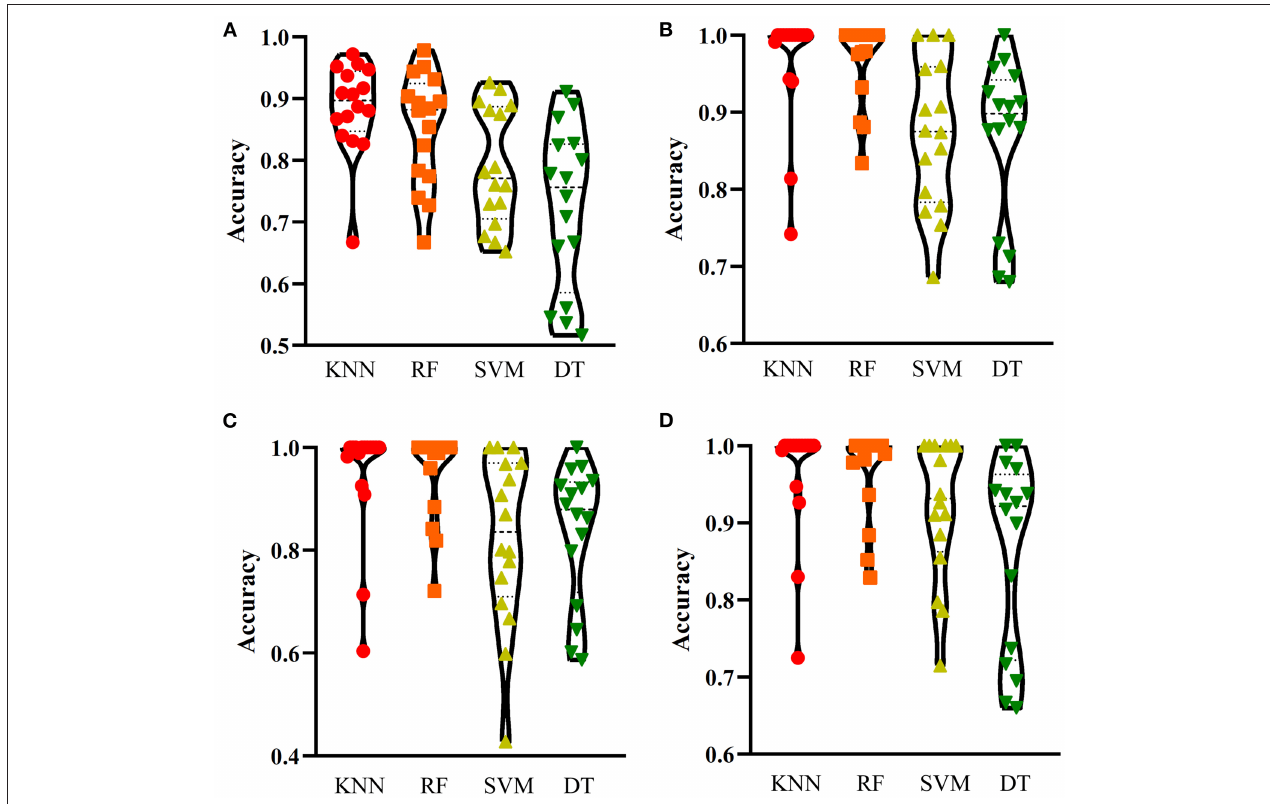
FIGURE 4 | Performance of the optimum classifiers on 16 categories with different feature types. (A) one-hot encoded representation derived from KEGG/GO terms; (B) functional embeddings from KEGG/GO terms; (C) network embeddings from a protein-protein network; (D) the combined functional and network embeddings. KNN, K-nearest neighbors; RF, random forest; SVM, support vector machine; DT, decision tree.